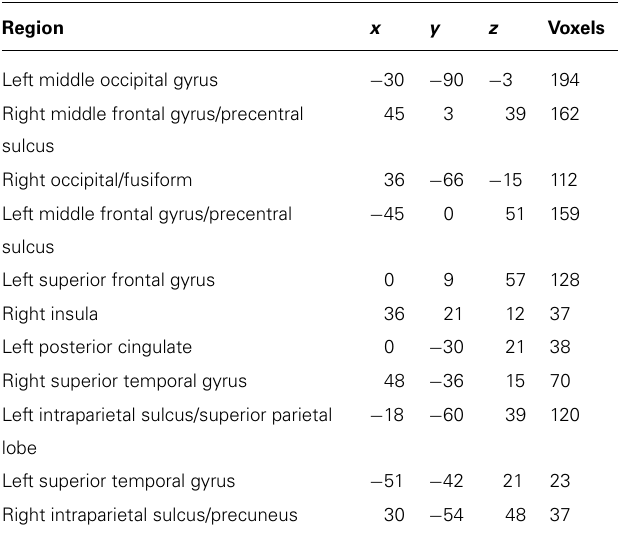
Table 2 |Whole-brain contrast for cue-only minus null-event activation. Region